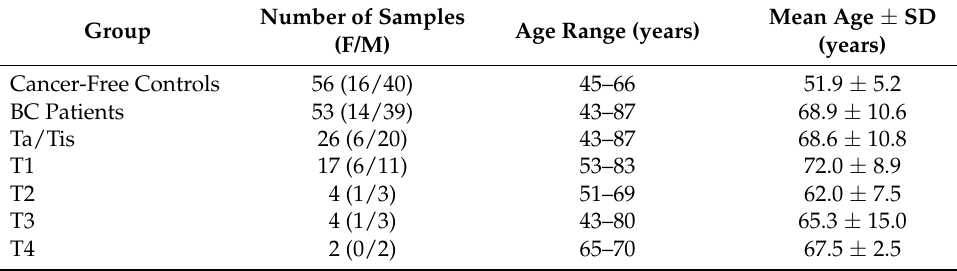
Table 1. Demographic and clinical data of cancer-free individuals and BC